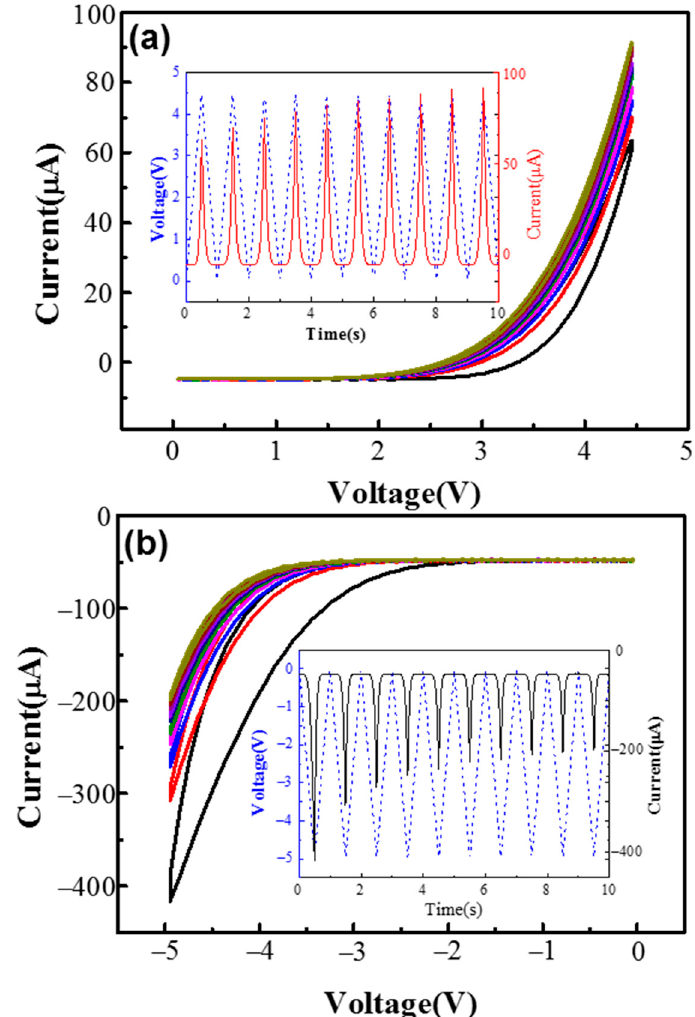
Figure 3. ( a ) Gradual SET under positive triangle pulses (from 0 to 4.5 V) (inset: the I-t and V-t curves of ( a ), representing the gradual increasing of current with time); ( b ) gradual RESET under negative triangle pulses (from 0 to − 5 V) (inset: the I-t and V-t curves of ( b ), representing the gradual decreasing of current with time).